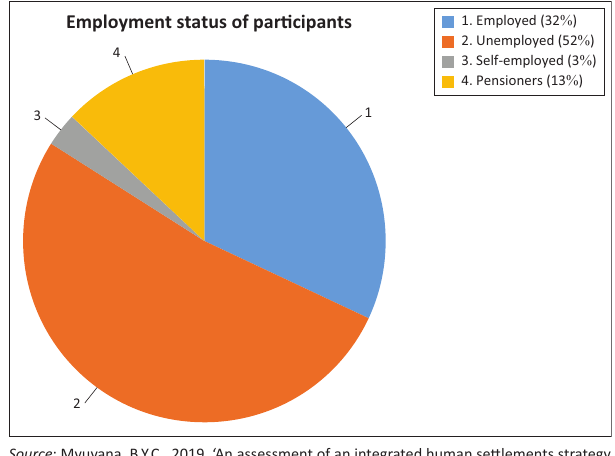
FIGURE 1: Employment status of